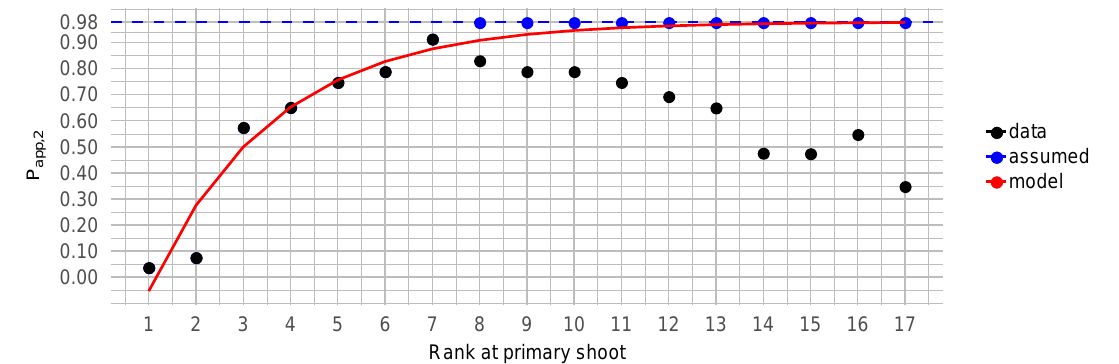
Figure 6. Estimated appearance probability for lateral shoots P app,2 (black dots) at specific ranks and model fit (red line, Equation (4)). Blue dots represent assumed maximum probability for not yet fully developed ranks at the measurement